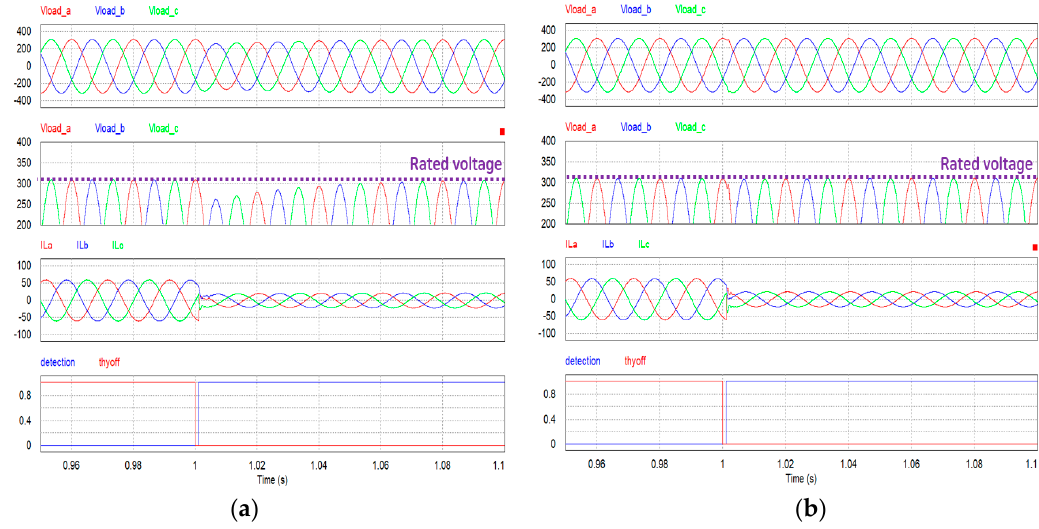
Figure 14. Simulation results of mode switching in the case of a grid fault during battery charging: ( a ) using the general inverter controller; ( b ) using the proposed load current compensation controller.